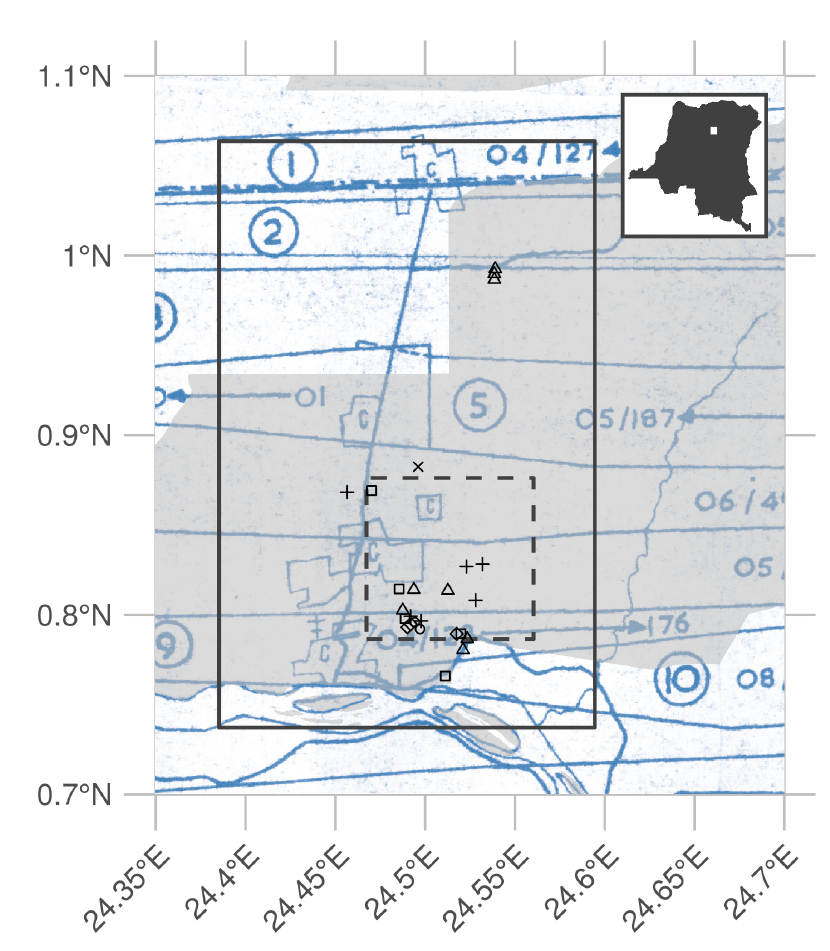
Figure 2. Overview of the historical flight paths during aerial photo acquisition and ancillary data used in this study: The bounding box of the orthomosaic data presented in this study is shown as a rectangle (23 × 36 km). The outline of a recent high-resolution Geo-Eye panchromatic image is shown as a dashed dark grey rectangle (10 × 10 km). The location of various permanent sampling plots are shown as x, +, and open squares and triangles for the mixed, mono-dominant, and edge plots, respectively. The grey polygon delineates the current-day Yangambi Man and Biosphere reserve. The inset, top right, situates the greater Yangabmi region (white rectangle) within the DR Congo. The full flight plan and details are shown in Appendix A Figures A1 and